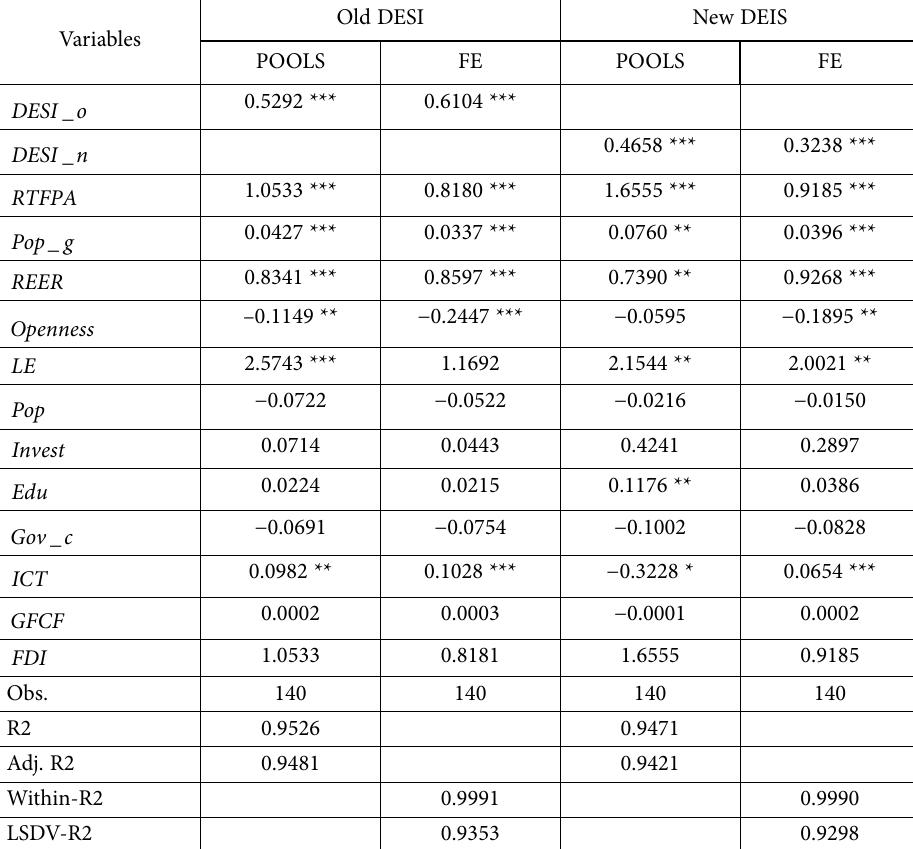
Table 5. GDP per capita estimates 2015–2019 – all countries #